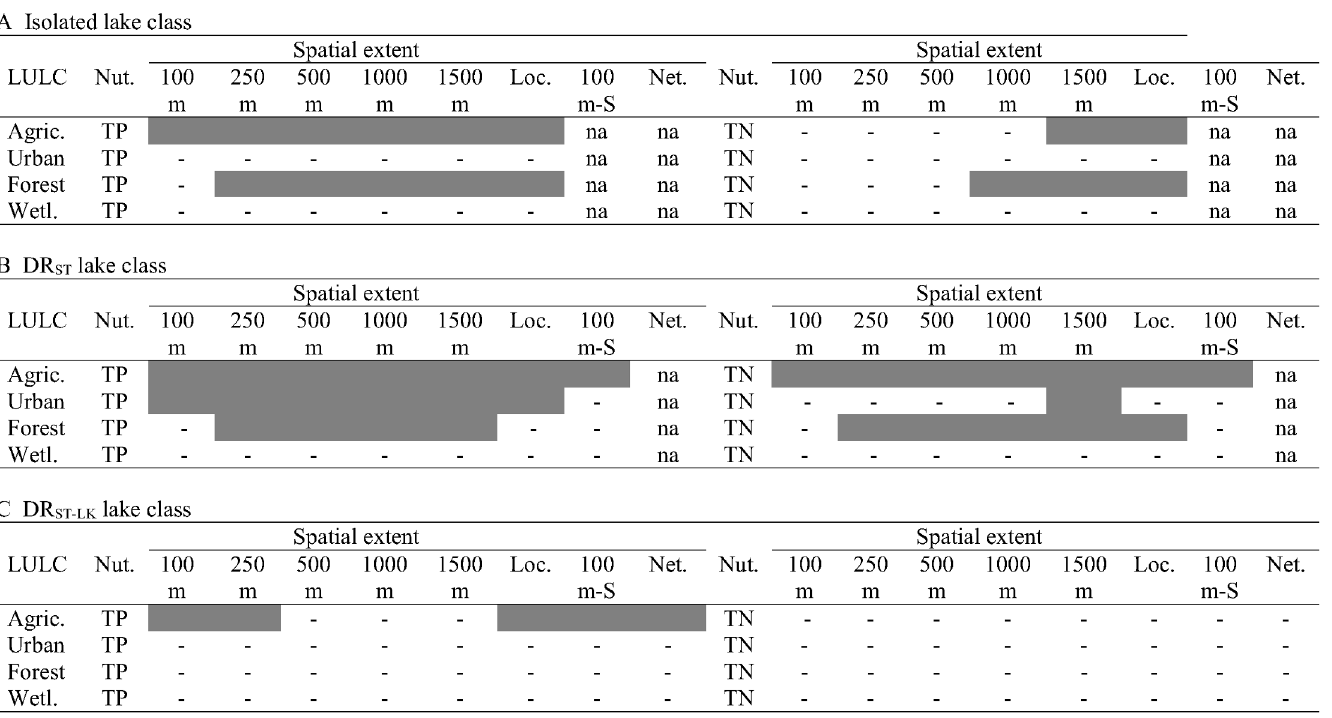
Fig 6. Synthesis of results by spatial extent and nutrient. The dark grey shading corresponds to evidence for a stronger relationship at one or more spatial extents than at the other non-shaded spatial extents based on both R 2 and the absolute value of the slope (larger positive or negative number indicating a stronger effect). Dashes indicate a lack of an ecologically relevant relationship (in which either the slope CIs overlap zero or an R 2 value close to zero). LULC is the land use/land cover type, Wetl. is wetland, Nut. is nutrient, Loc. is local catchment, 100m-S is the 100 m zone around inflowing streams, Net. is the network catchment. The DR ST lake class includes drainage lakes with streams flowing in; and the DR ST-LK lake class includes drainage lakes with streams flowing in and upstream lakes (cid:1) 10